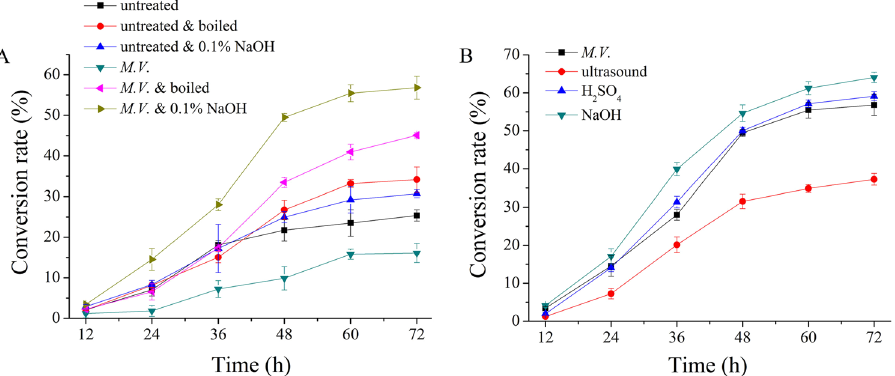
Figure 7. Comparison of the enzymolysis effects of pretreated corn stover by different methods during enzymatic hydrolysis for 72 h. ( A ) Stands for the enzymolysis effects of bio-pretreated corn stover with different regeneration methods; ( B ) stands for the enzymolysis effects of corn stover by different pretreatment methods. Each value is the mean of the three